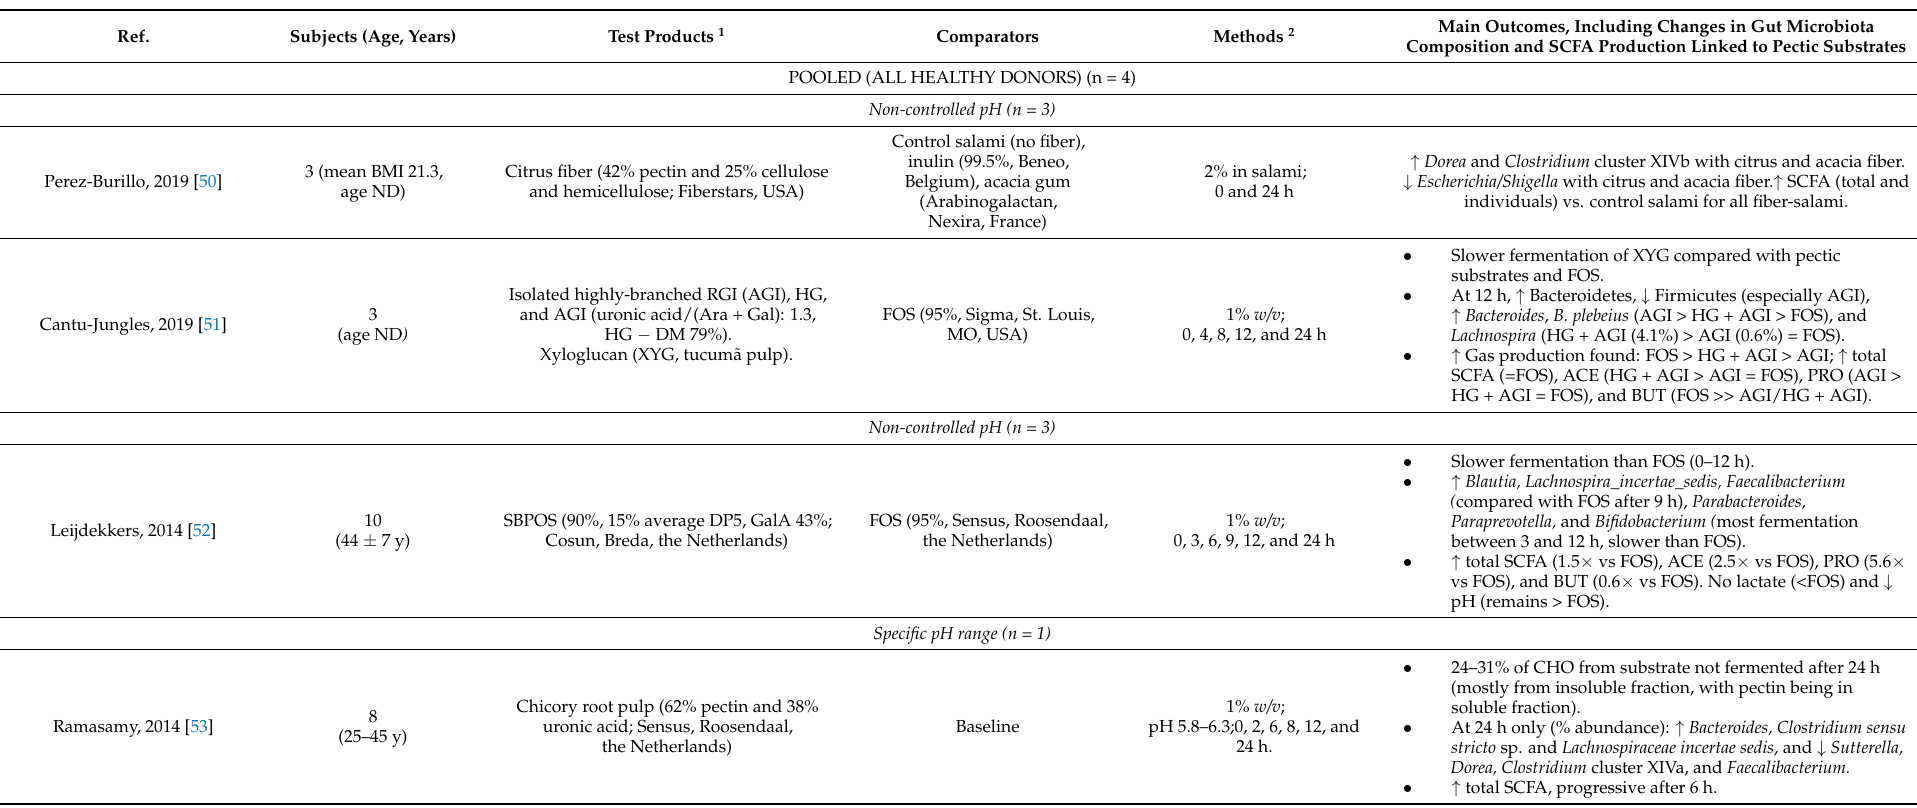
Legend: Upward arrows indicate an increased bacterial abundance, and downward arrows indicate a decreased bacterial abundance. 1 Test products were described as in the studies. They were produced under laboratory conditions when no supplier is mentioned. 2 Concentration, sampling time, and microbiota determination. All studies used a non-targeted bacterial group determination approach within their methodology unless specified. 3 ACE: acetic acid; Ara: arabinan; AOS: arabino-oligosaccharides; BUT: butyric acid; CHO: carbohydrates; DE: degree of esterification; DM: degree of methylation; DP; degree of polymerization; FOS: fructo-oligosaccharides; Gal: galactose; GalA: galacturonic acid; GOS: galacto-oligosaccharides; GLOS: gluco-oligosaccharides; HG: homogalacturonan; IMMP: isomalto/malto-polysaccharides; ISOBUT: isobutyric acid; ISOVAL: isovaleric acid; LAC: lactate; MW: molecular weight; MP: modified pectin; OGalA: oligogalacturonides; PGalA: polygalacturonic acid; POS: pectic oligosaccharides; PRO: propionic acid; Rha: